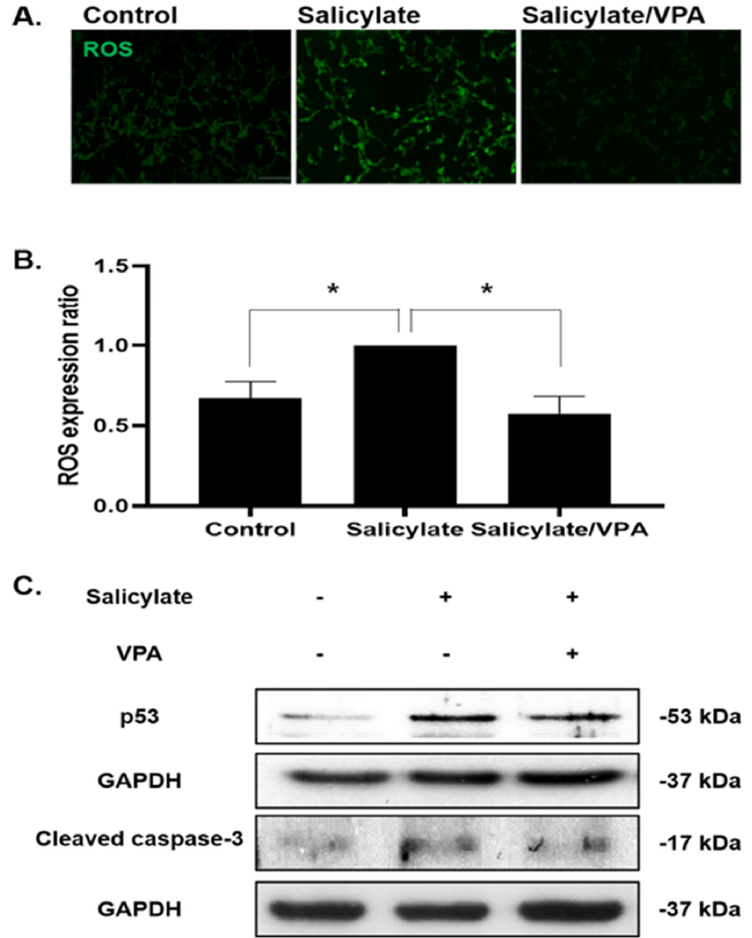
Figure 3. VPA prevents oxidative damage in salicylate ‐ treated cells ( A ) Intracellular ROS levels were increased in salicylate ‐ treated SH ‐ SY5Y cells and significantly decreased in VPA ‐ pretreated cells, as observed by immunocytochemical staining (scale bar = 100 μ m). ( B ) ROS levels were quantified using Image J software and are presented in the graph (* p < 0.05, mean ± SD, n = 4). ( C ) Immunobloting was performed using antibodies against p53 and cleaved caspase ‐ 3. The expression levels of the tested proteins were decreased by VPA pretreatment. GAPDH was used as an internal standard.